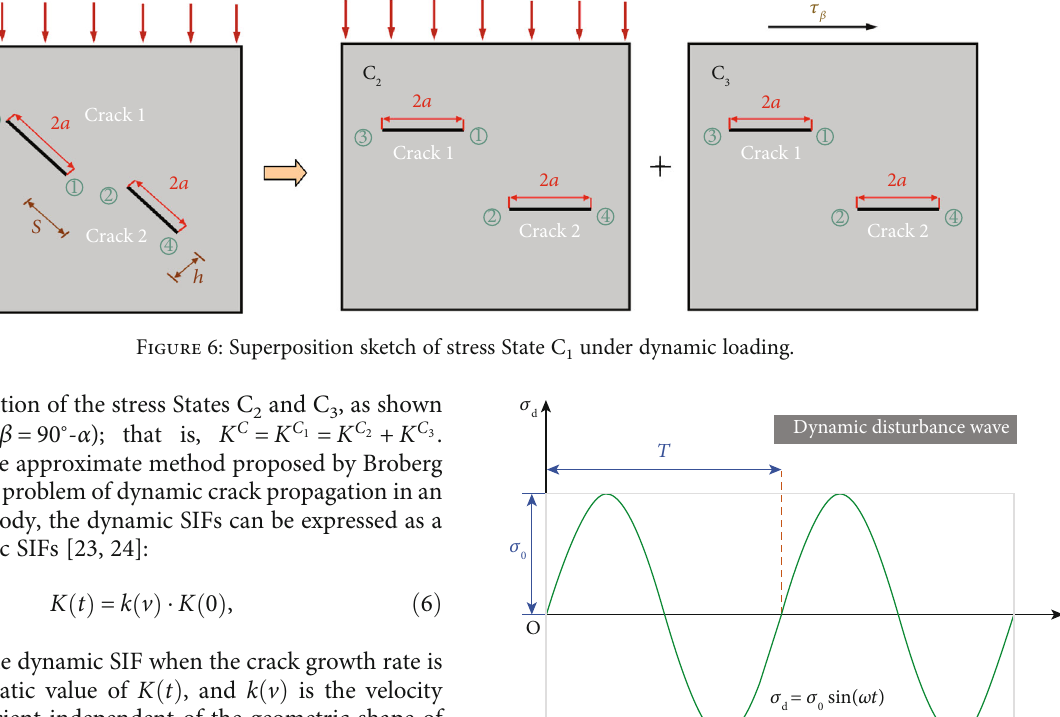
Figure 7: Dynamic disturbance